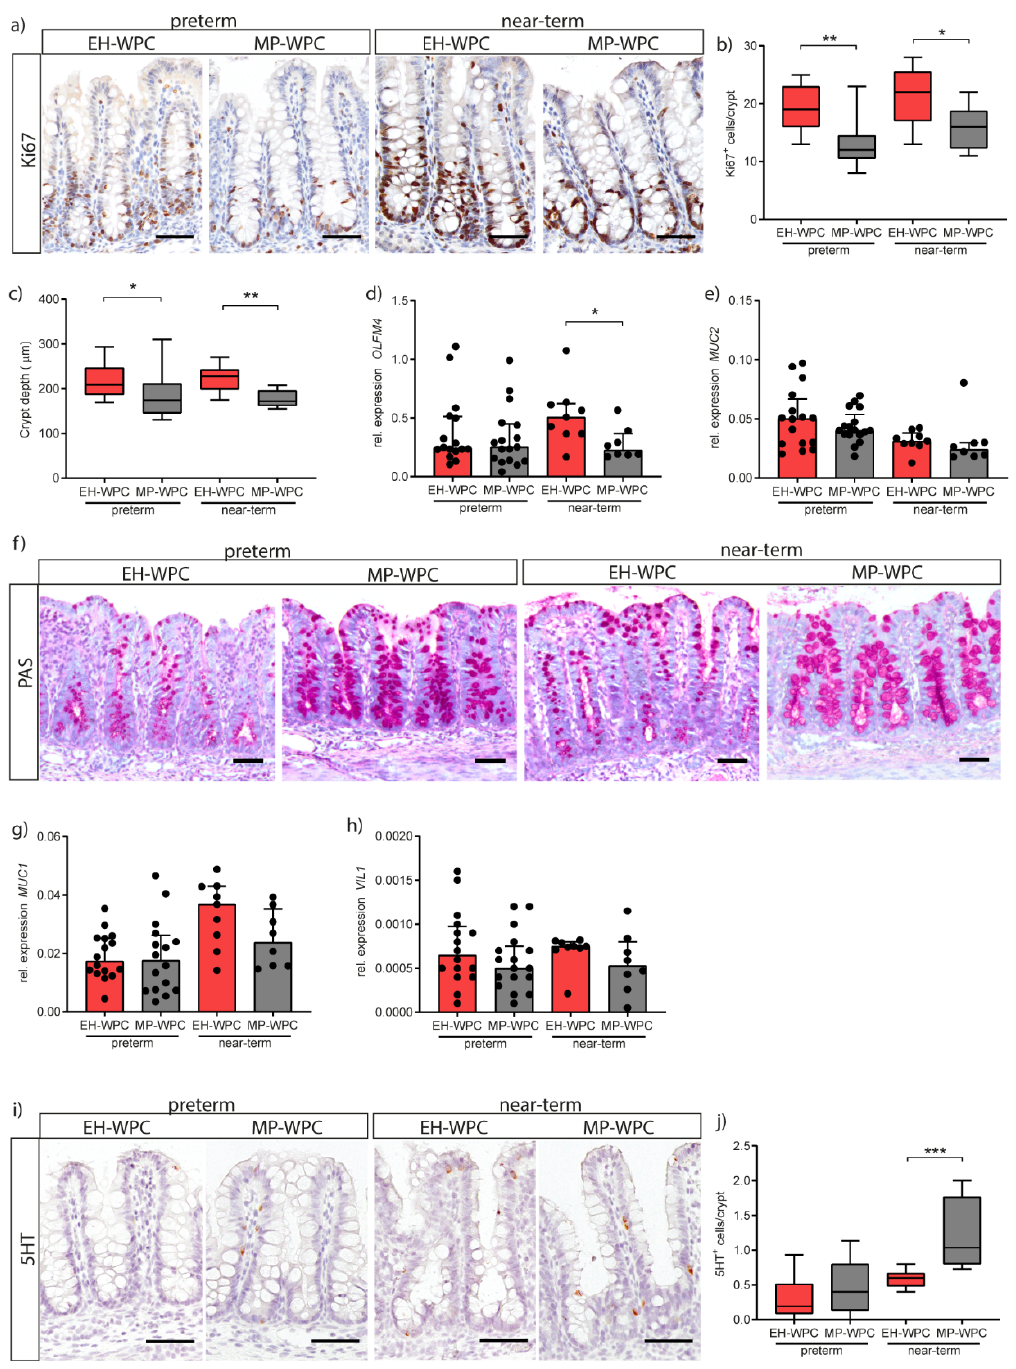
Figure 4. MP ‐ WPC affects colonic crypt proliferation & differentiation. ( a ) Proliferating cells in the colon crypt were identified by immunohistochemistry staining for Ki67 with ( b ) quantification of the number of Ki67 + cells per crypt. ( c ) Colon crypt depth evaluated by ImageJ analysis. Relative expression levels of stem cell marker ( d ) OLFM4 and goblet cell marker ( e ) MUC2 as determined by RT ‐ qPCR and ( f ) detection of mucus ‐ containing cells in the colon by Periodic ‐ Acid Schiff’s (PAS) staining. Relative expression levels of ( g ) MUC1 and ( h ) VIL1 in the colon as determined by RT ‐ qPCR. ( i ) enterochromaffin cells in de colon were detected by immunohistochemistry staining for serotonin (5HT) and ( j ) number of 5HT + cells per crypt were quantified. Values are median ±IQR, * p ≤ 0.05 ** p ≤ 0.01 *** p ≤ 0.001. Scalebar equals 50 μ m.